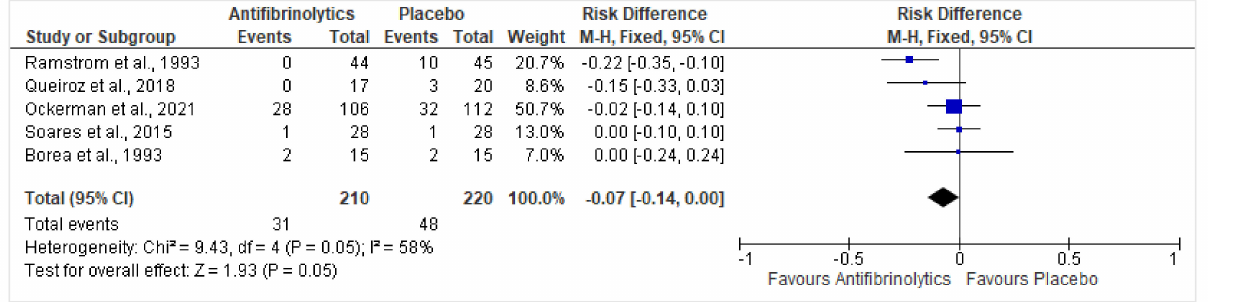
Figure 2. Risk difference (RD) for postoperative bleeding outcomes across the entire cohort of included patients [22–26]. Heterogeneity: Chi 2 = 9.43, df = 4 ( p = 0.05); I 2 = 58%. Test for overall effect: Z = 1.93 ( p =